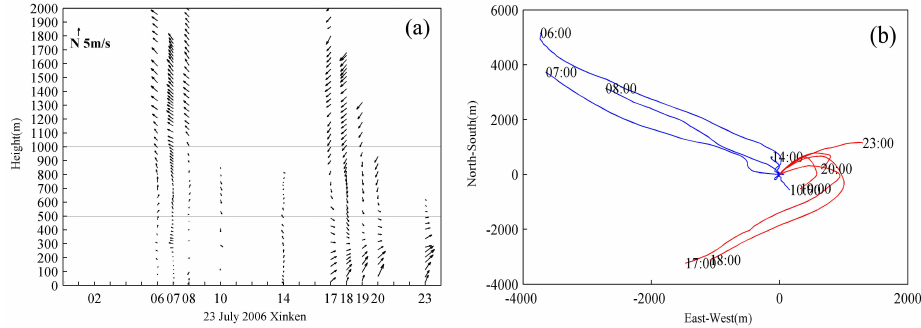
Fig. 6. Vertical wind profiles obtained using radio soundings and balloon trajectories on 23 July 2006 at the Xinken